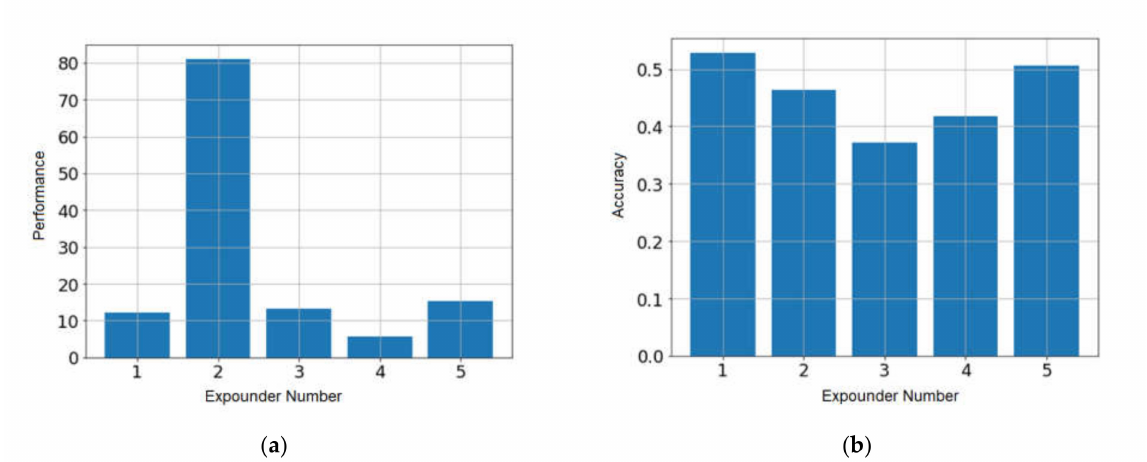
Figure 6. Comparative evaluation of the expounders: ( a ) performance, ( b ) accuracy.